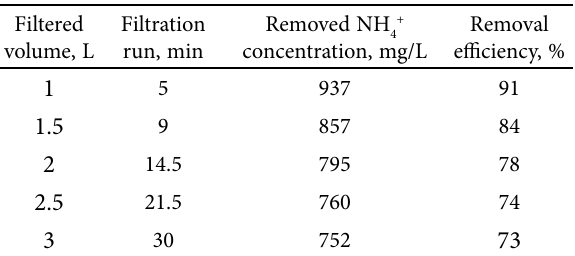
Table 5. Ammonium ions removal, using column test (zeolite particles size 1.6–2.5 mm)